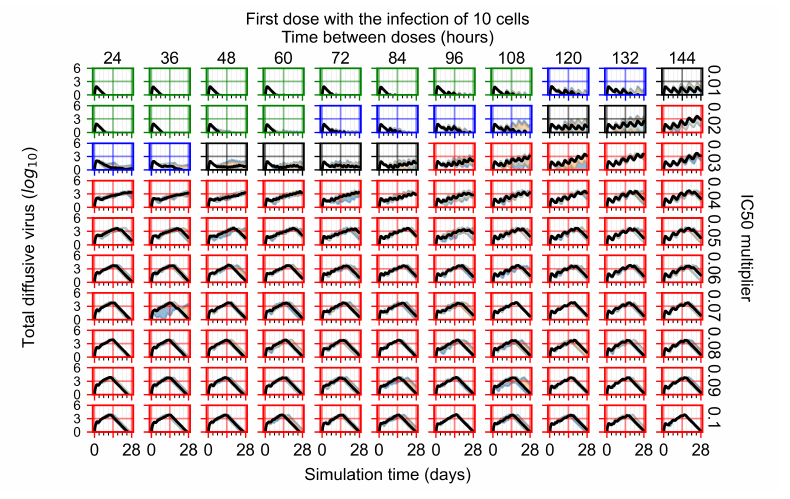
Figure 10. Extracellular diffusive virus populations for eight replicas of the treatment simulation. Treatment starts with the infection of 10 cells, the half-life of GS-443902 was halved (to 15.2 h). For all subfigures, the median measurement of simulation replicas is the black line, the 0th to 100th quantiles are shaded as dark blue, 10th to 90th shaded in orange, and 25th to 75th as light blue. Rapid clearance plot axis in green, slow clearance plot axis in blue, partial containment in black, and widespread infection in